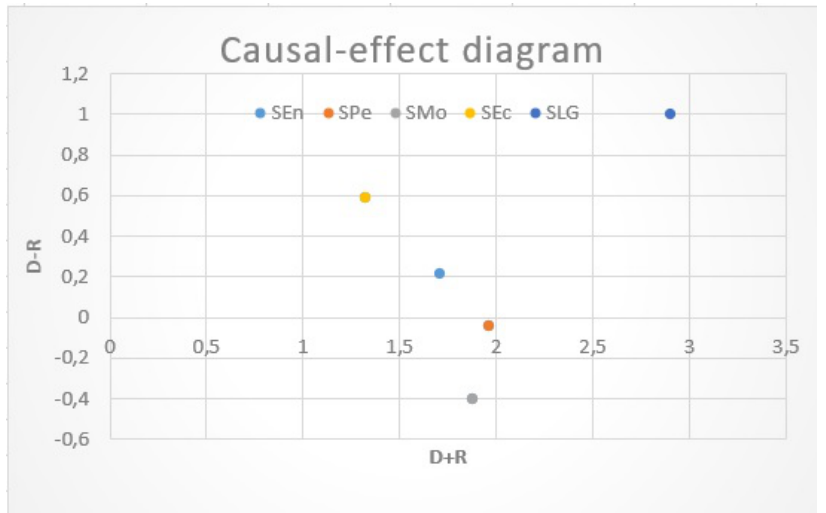
Figure 5. The causal-e ff ect diagram for various